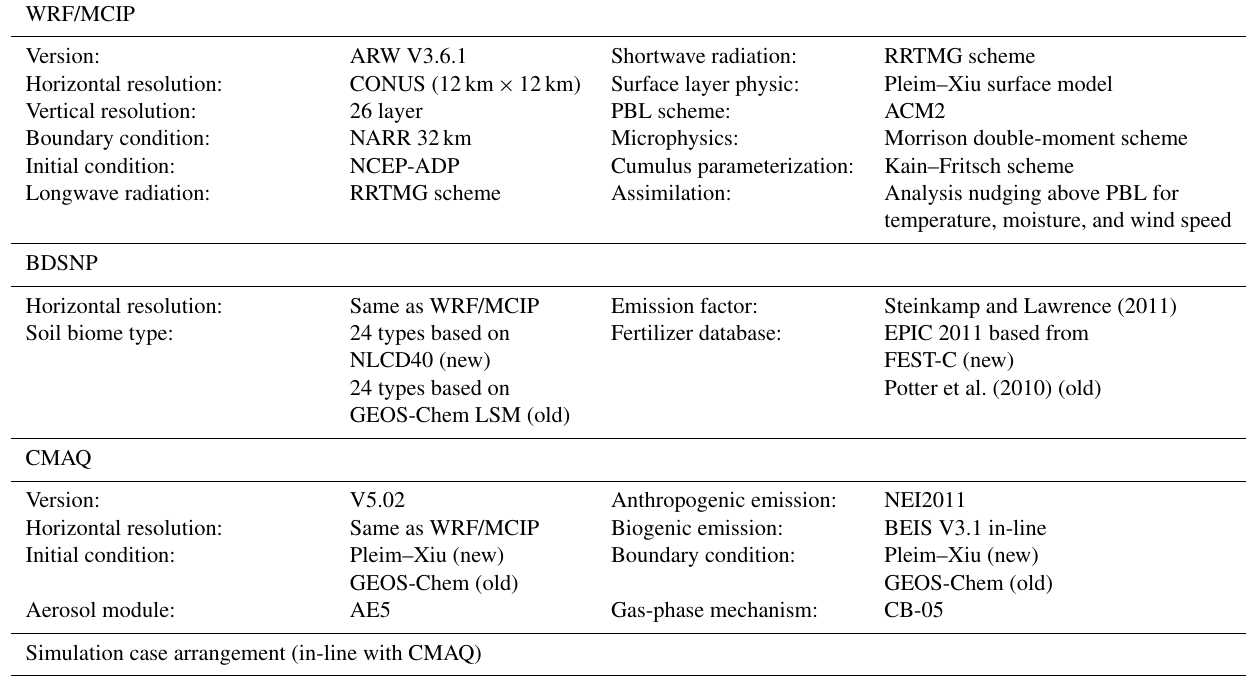
Table 1. Modeling configuration used for the WRF–BDSNP–CMAQ CONUS domain